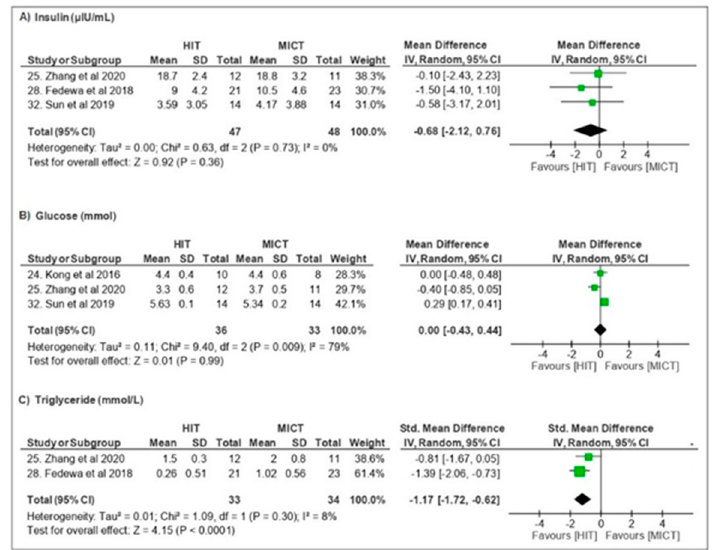
Figure 5. Forest plot of the effects of HIT vs. MICT intervention on outcomes: ( A ) insulin, ( B ) glucose and ( C ) triglyceride; HIT: high-intensity interval training; MICT: moderate intensity continuous training; IV—inverse of the variance; CI: confidence interval; SD: standard deviation.